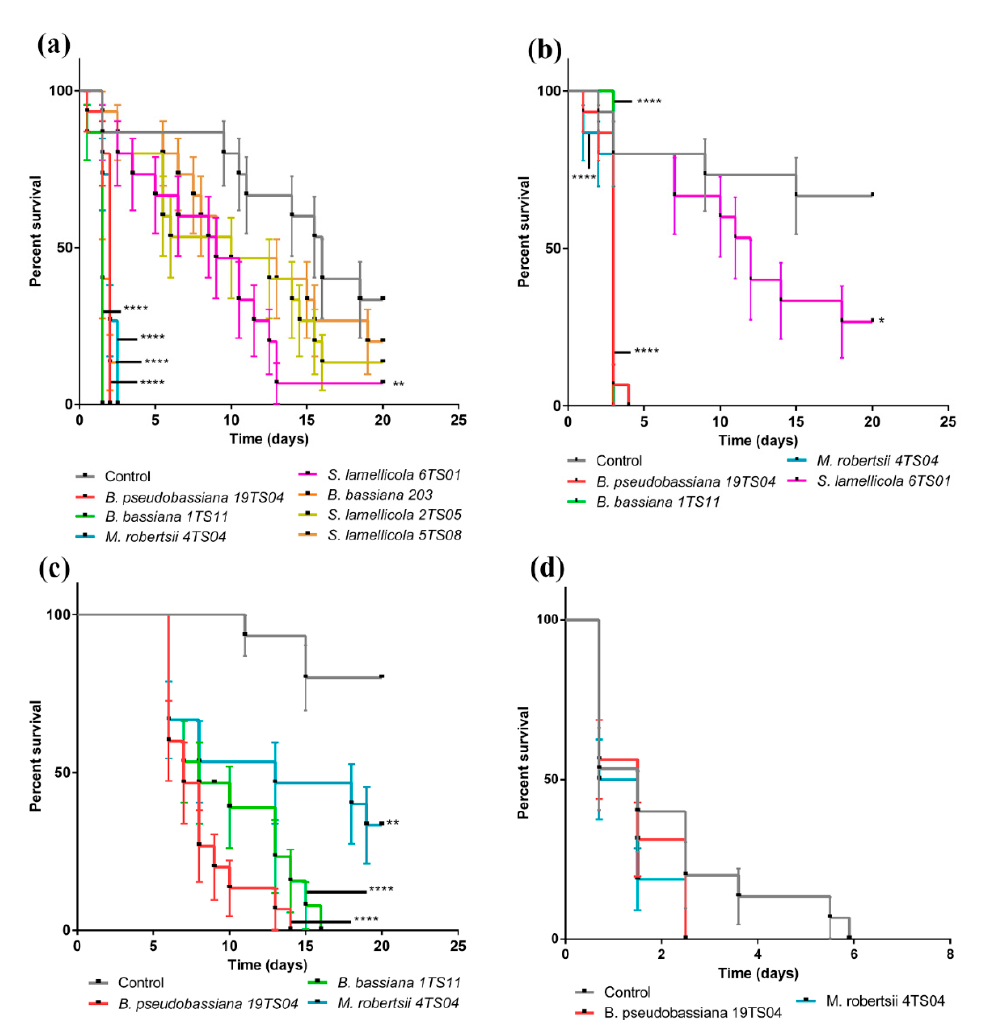
Figure 1. Entomopathogenic fungi isolated from banana crop soils are pathogenic over G. mellonella larvae and C. sordidus ( n = 15). ( a ) Beauveria spp. and M. robertsii isolates are the most virulent on the larvae in the CMA plate bioassay. ( b ) In the dipping bioassay at 10 7 conidia / mL the most virulent fungi are Beauveria spp. and M. robertsii . ( c ) Beauveria spp. isolated from banana crop soils of Tenerife are more virulent than M. robertsii 4TS04 on C. sordidus adults. ( d ) Entomopathogenic fungi isolated from banana crop soils are pathogenic over C. sordidus larvae. Asterisks indicate significant differences (* p < 0.05, ** p < 0.01, *** p < 0.001 and **** p < 0.0001) respect to the control.